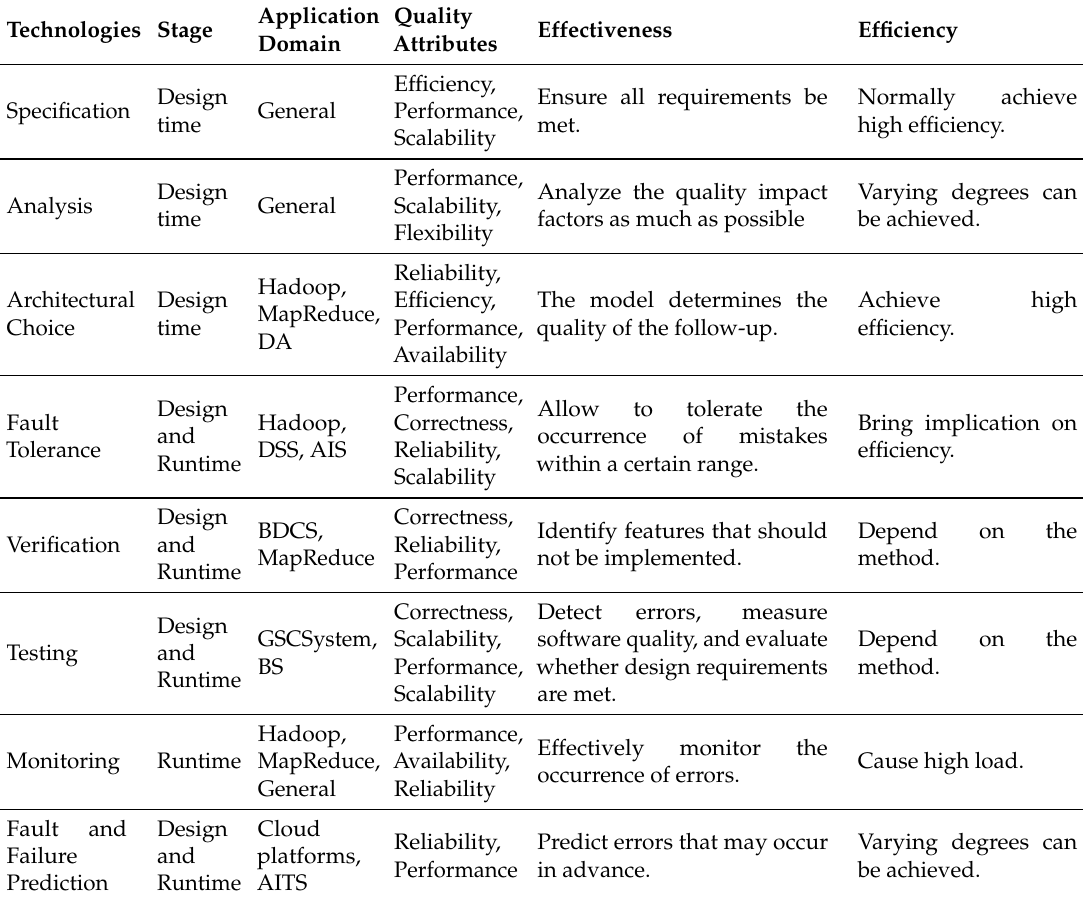
Table 11. Comparison of QA